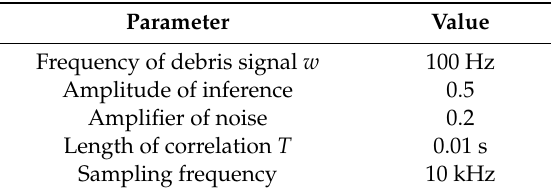
Table 4 . Simulation parameters.